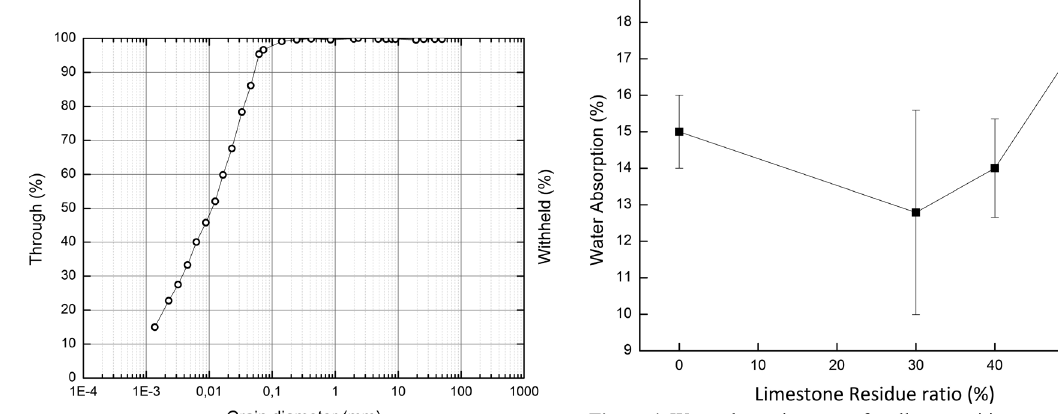
Figure 4. Water absorption curve for all